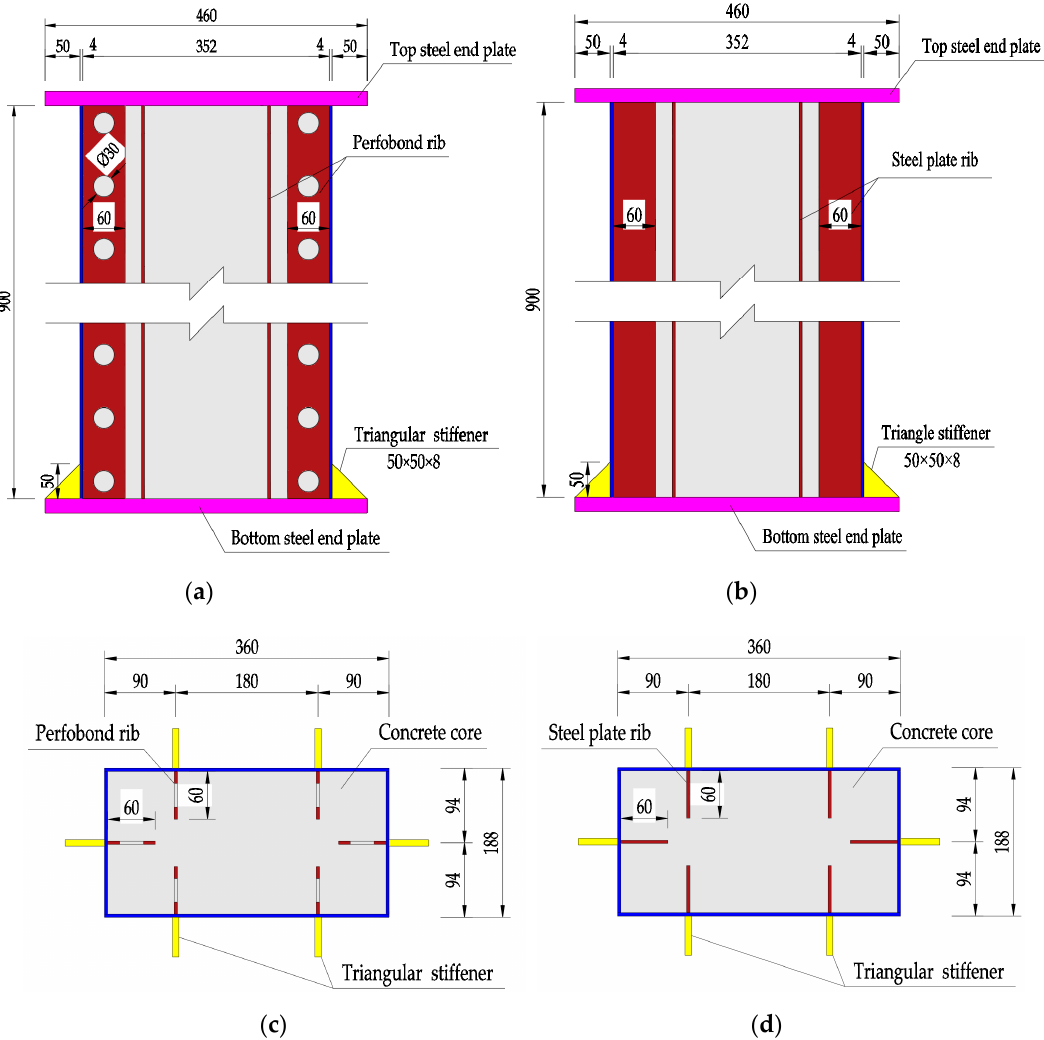
Figure 1. Details of columns with stiffeners (dimensions in mm). ( a ) Vertical view of perfobond ribs; ( b ) vertical view of steel plate ribs; ( c ) cross section of perfobond ribs; ( d ) cross section of steel plate ribs. Unit: mm.